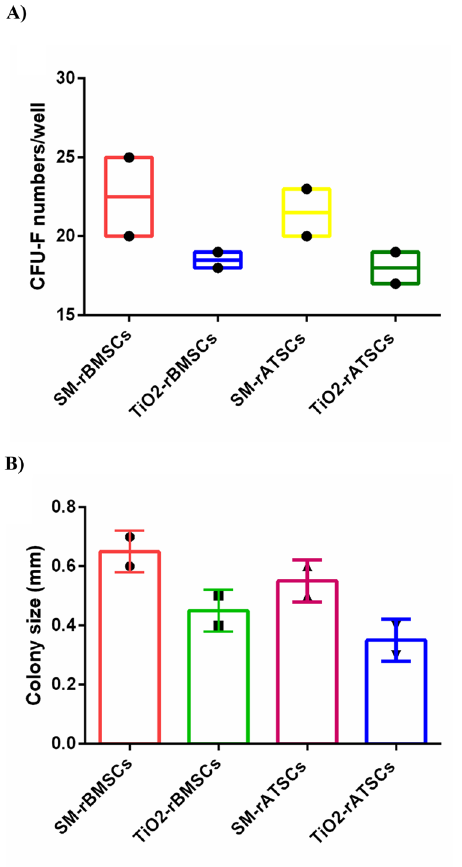
Fig. 7 A The colony numbers of rBMSCs or rATSCs treated with standard medium (SM) or treated with TiO 2 . B The colony size of rBMSCs or rATSCs treated with SM or TiO 2 (data was shown as mean ± of model cells, both rATSCs and rBMSCs were studied to con fi rm the characteristics of MSCs, surface CD markers, osteogenic differentiation, and morphological phenotype.